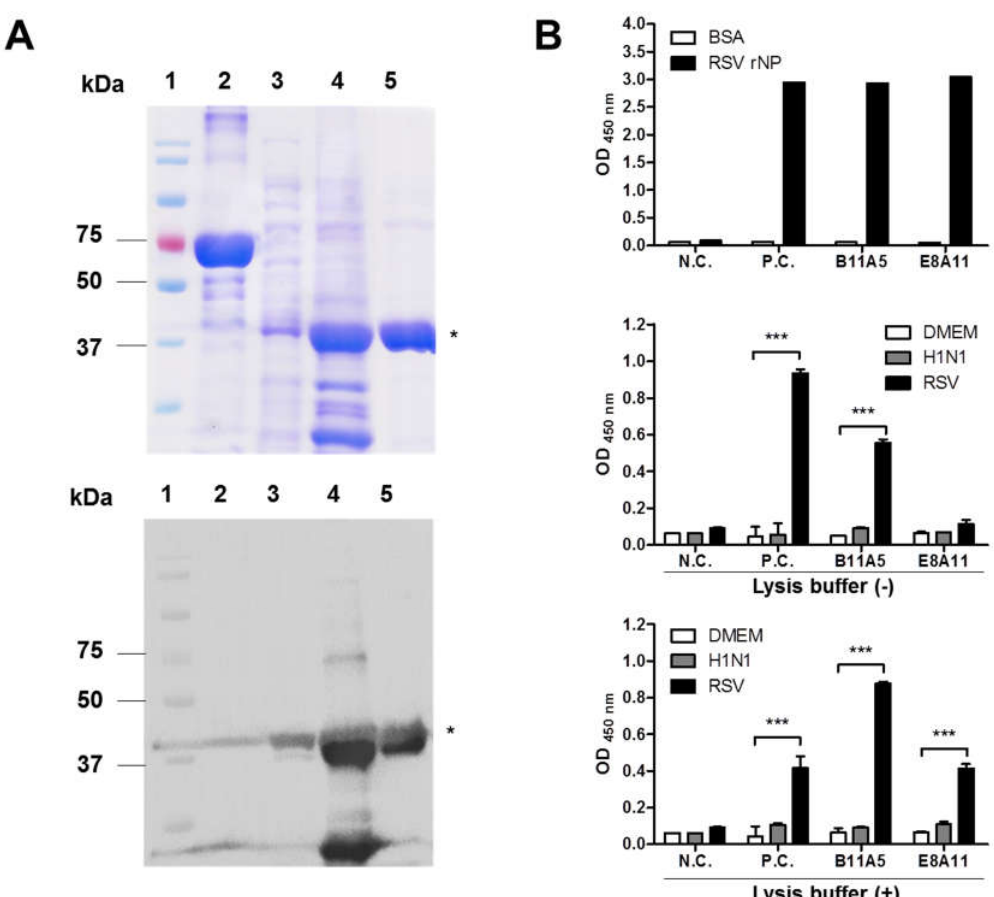
Figure 1. Development of antigen and antibody. ( A ) Recombinant respiratory syncytial virus nucleoprotein (RSV-NP) was expressed in an E. coli system and purified using a nickel nitrilotriacetic acid (Ni-NTA Agarose). The upper panel shows the SDS-PAGE results, and the lower presents Western blot results with an anti-His-6 × tag antibody. 1, marker; 2, bovine serum albumin (BSA); 3, supernatant after induction; 4, pellet after induction; 5, purified RSV recombinant NP (rNP). The asterisk (*) indicates the target band. ( B ) Secreted antibodies in the supernatants of two hybridomas were tested with recombinant NP (10 µ g/mL) using Dulbecco’s Modified Eagle Medium (DMEM) and Influenza A H1N1 virus as negative control. Finally, purified antibodies (B11A5 and E8A11) were tested with virus (1 × 10 7 TCID 50 /mL) by performing an indirect ELISA in the absence or presence of lysis buffer. Two-way ANOVA. *** p < 0.001.